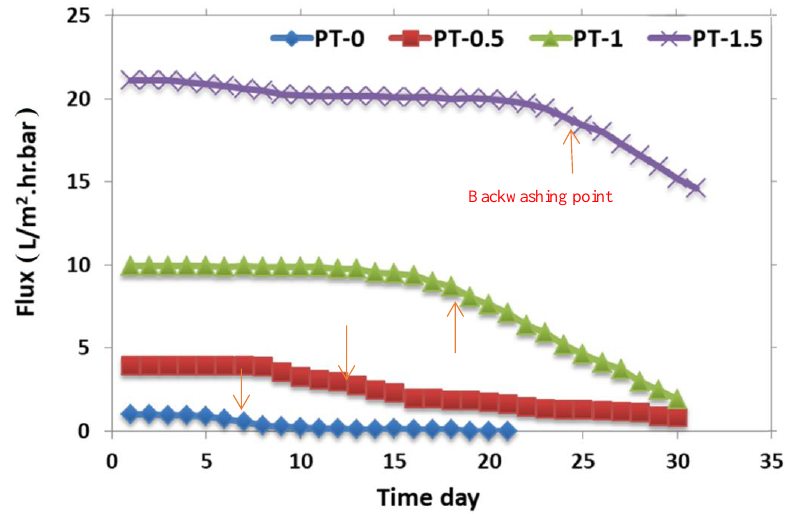
Figure 10. The effect of TiO 2 NPs in casting solution on long-term of the prepared membranes: (PT-0) 0 gm TiO 2 ; (PT-0.5) 0.5 gm TiO 2 ; (PT-1) 1 gm TiO 2 ; and (PT-1.5) 1.5 gm TiO 2 , by using oily wastewater with characteristics of chemical oxygen demand (COD) ~290 mg / L; PH ~6.9; total suspended solid (TSS) ~146 mg / L; and turbidity ~20.7 NTU; heavy metals (Zn = 82.3 µ g / L; Mn = 0); and oil and grease ~40.14 mg /